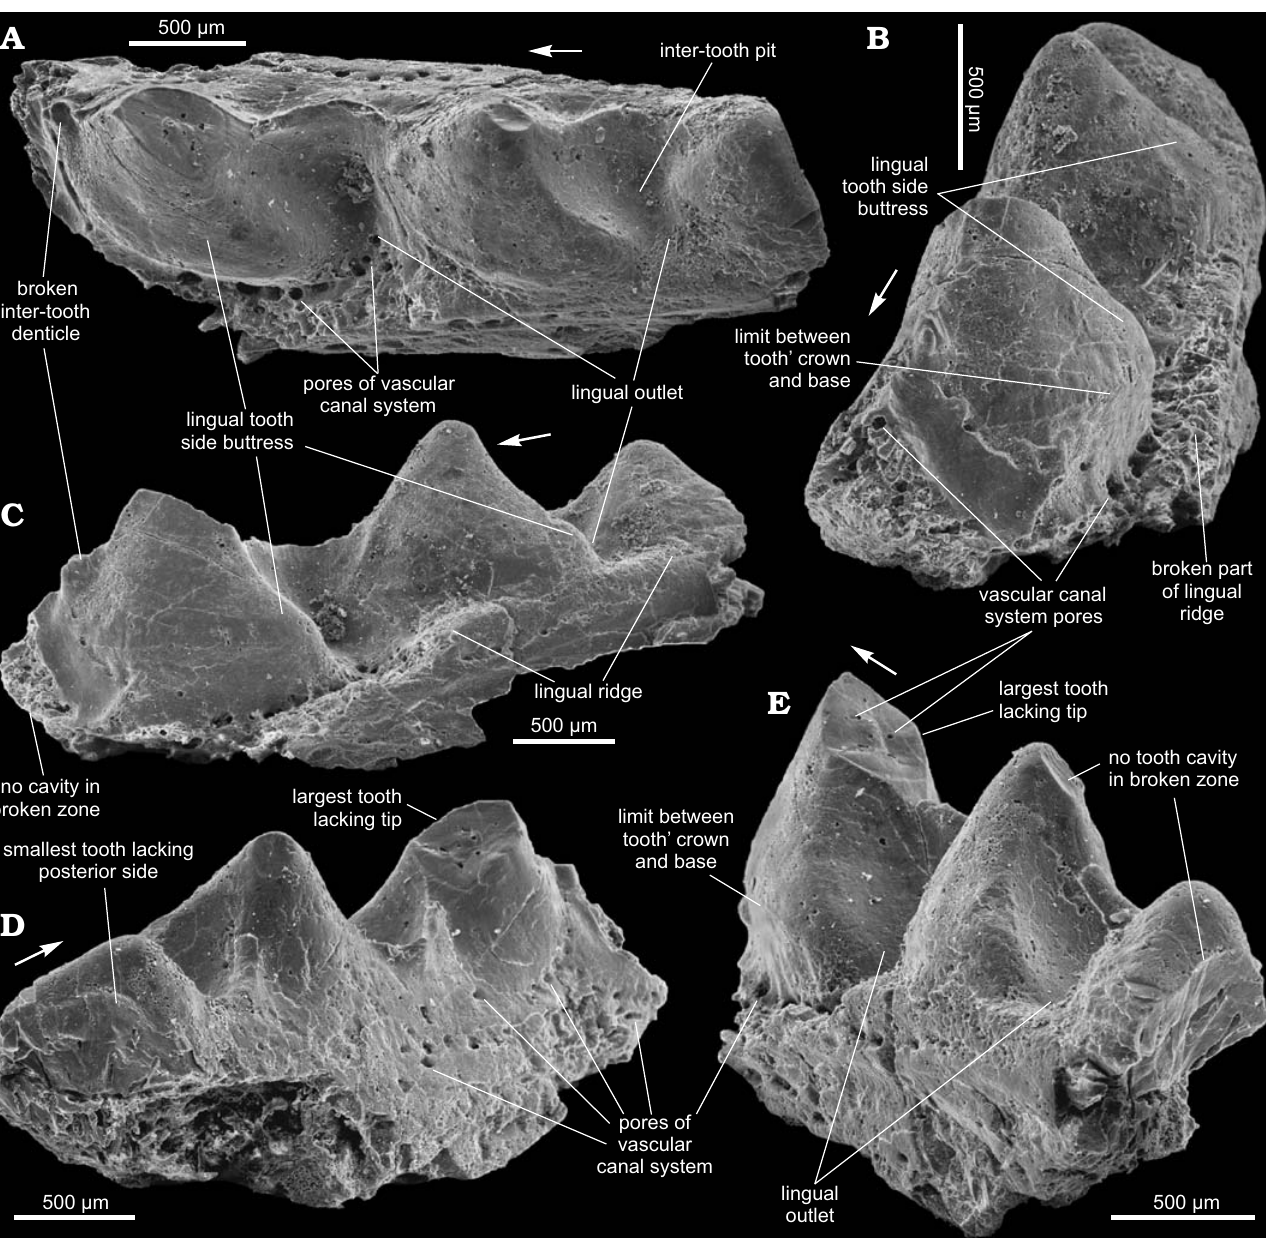
Fig. 8. Ischnacanthiformes fam. gen. et sp. indet., SMNH BP.1586/4, Dniester River, opposite Zalishchyky, Zastavna (Chernivtsi) region (Podolia), Ukraine; upper part of Ivanie Horizon of the Tyver Series, Lower Devonian; jaw bone fragment in occlusal ( A ), antero-linguo-occlusal ( B ), antero-lingual ( C ), postero-lateral ( D ), and postero-lingual ( E ) views. Arrows indicate rostral